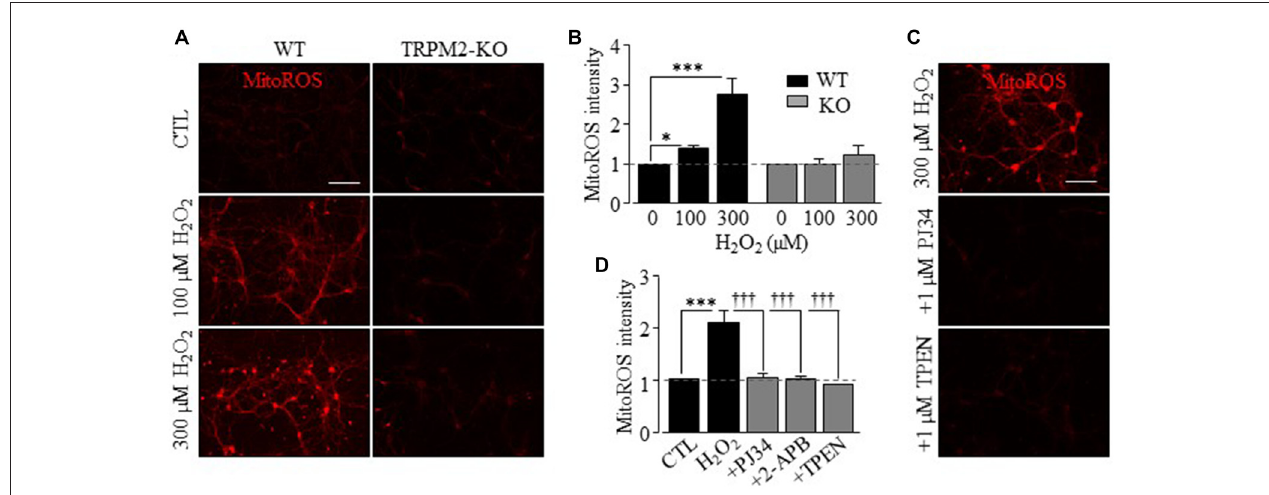
FIGURE 6 | TRPM2 channel is crucial for H 2 O 2 -induced production of mitochondrial reactive oxygen species (ROS) in hippocampal neurons. (A,C) Representative fluorescence images showing MitoTracker Red CM-H 2 Xros (MitoROS) fluorescence in WT (left column) or TRPM2-KO (right column) neurons under control (CTL) and treatment with 100 µ M or 300 µ M H 2 O 2 for 2 h (A) , or in WT neurons treated with 1 µ M PJ34 or 1 µ M TPEN, 30 min before and during exposure to 300 µ M H 2 O 2 (C) . Scale bar is 100 µ m. (B,D) Mean MitoROS fluorescence intensity from 3 to 5 independent experiments with 35–70 neurons examined in each experiment, presented relative to the fluorescence level in control neurons in matched experiments. 2-APB was used at 100 µ M. ∗ p < 0.05 and ∗∗∗ p < 0.005 indicate significant difference from control. ††† p < 0.005 indicates significant difference from neurons exposed to 300 µ M H 2 O 2